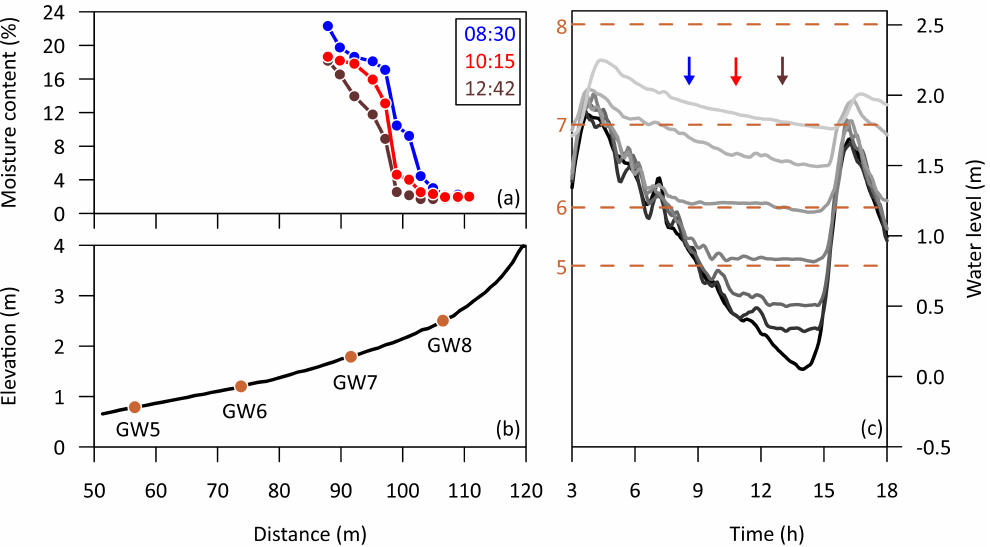
Figure 7. ( a ) Surface moisture content w s at three time intervals during falling tide and ( b ) bed elevation z versus cross-shore distance x on 6 October, at the end of the storm surge that peaked on the previous and night. ( c ) shows time series of water level at six groundwater wells, GW8 (light gray) down to GW3 (dark gray). The black line is the water level at the PT. The three vertical arrows mark the moment of moisture sampling, with the same color coding as in ( a ). The four dashed brown lines are the bed elevation at (top to bottom) GW8 to GW5, see also ( b